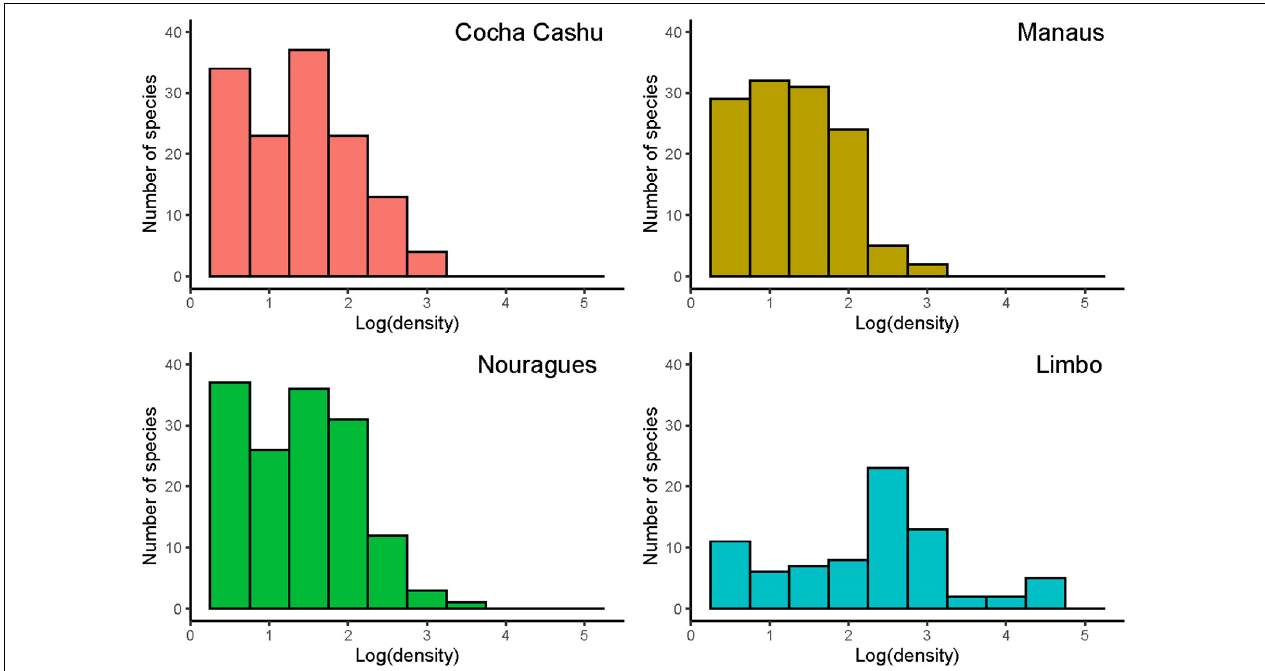
FIGURE 2 | Population density (log 2 intervals) across species in the four Neotropical bird communities where density was estimated. The South American sites (Cocha Cashu, Manaus, and Nourages) are largely similar but quite different from the Central American site